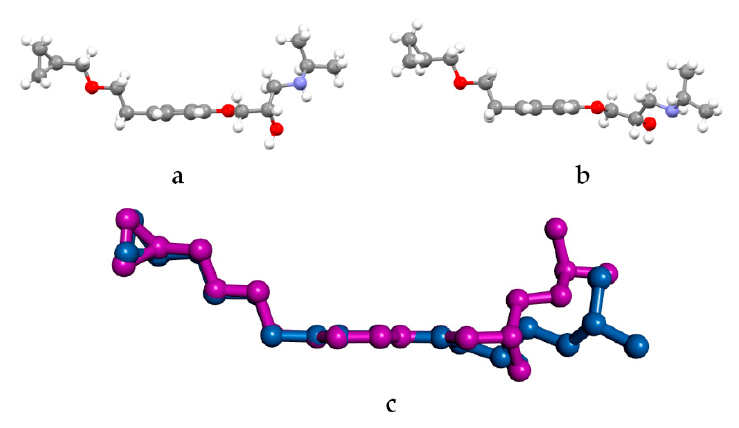
Figure 3. ( a ) Ball and stick view of the conformation of betaxolol in BE_IV ; ( b ) ball and stick view of the conformation of betaxolol in BE_I ; ( c ) superimposition of betaxolol in BE_I (blue) and BE_IV (pink). For sake of clarity only the set of coordinates having the highest occupancy factor has been reported.